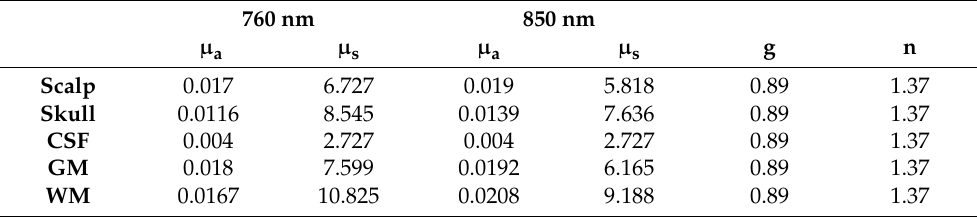
Table 1. Optical properties of the five-layered model employed in Monte Carlo forward